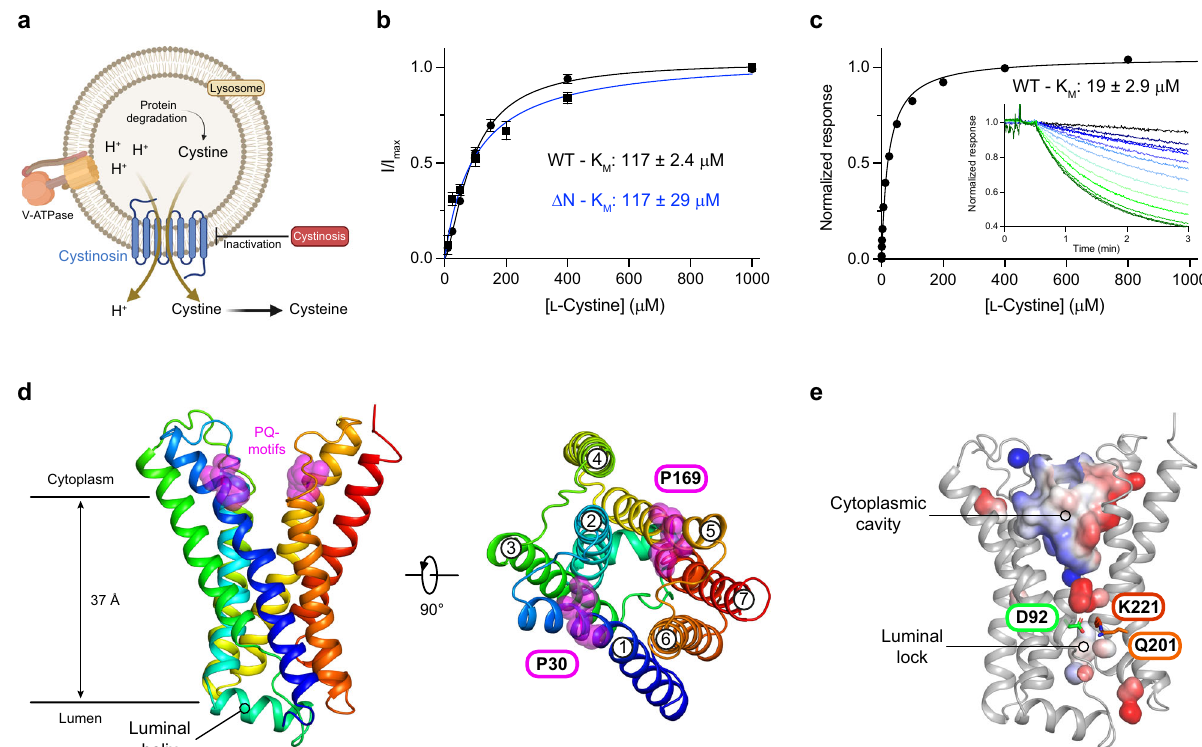
Fig. 1 | Functional characterisation and structure determination of cystinosin. a Cystinosinresideswithinthelysosomalmembranewhereitisresponsible forthe exportof cystine from the lysosomallumen. Transportisproton coupled,utilising the proton gradient across the membrane generated through the action of V-ATPase.MutationoftheCTNSgene,whichencodescystinosin,leadtocystinosis. b RepresentativeK M curvederivedfromTEVCforfulllengthhumancystinosin(WT – black) and a construct lacking N-terminal amino acids 2-115 ( Δ N – blue). n =16 independent experiments for every WT data point, n =10 for Δ N, error bars SEM. K M values were calculated from three biologically independent experiments, error SD. c RepresentativeK M analysisofplantcystinosinderivedusingapyraninebased